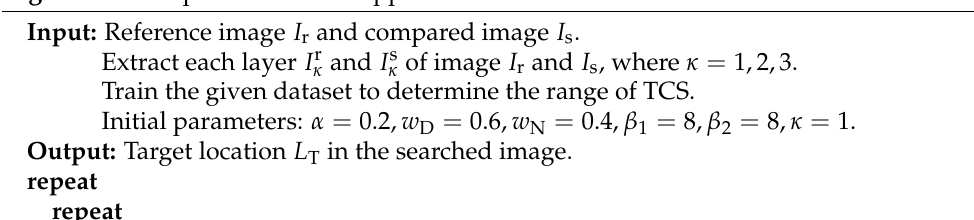
Algorithm 1 Proposed ABC-ML